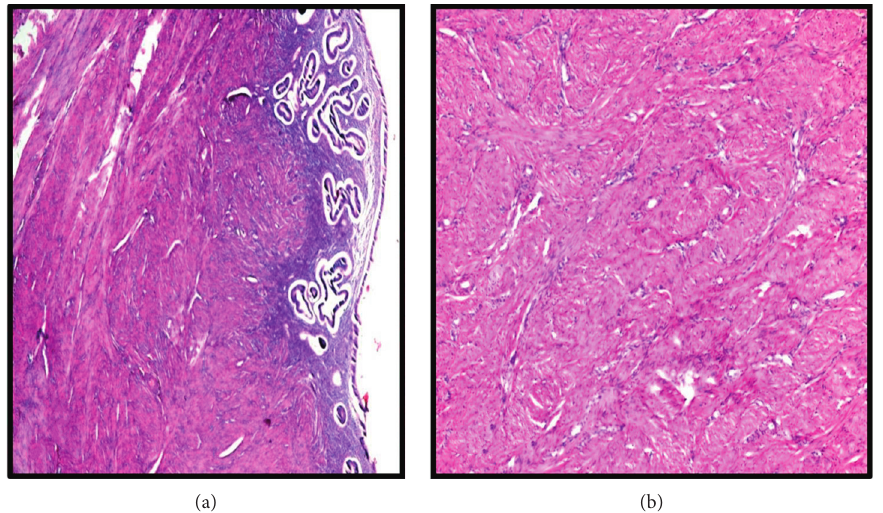
Figure 2: Histopathological examination of the pelvic mass shows (a) normal endometrial tissue in the innermost layer (hematoxylin and eosin, × 200) surrounded by (b) thick myometrial-type muscular layer (hematoxylin and eosin, × 200). Histopathological findings resembled a normal uterus, confirming the diagnosis of accessory and cavitated uterine mass.